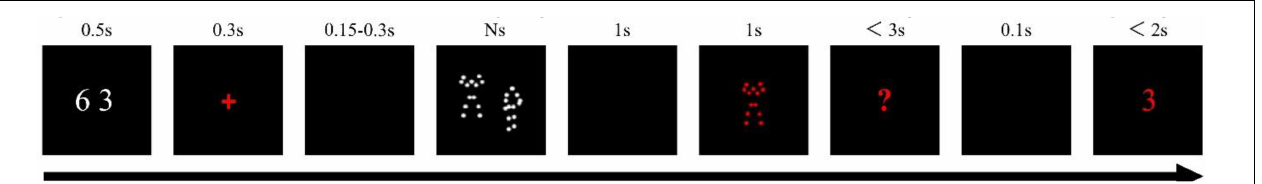
FIGURE 1 | A schematic demonstration of procedures for measuring BM-WM